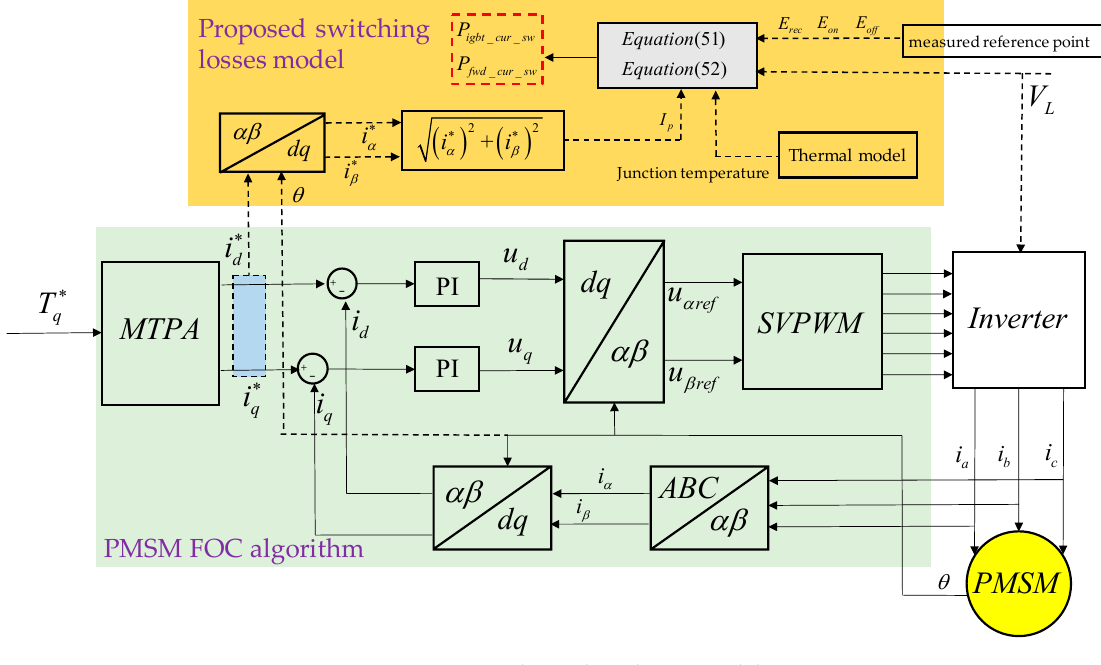
Figure 7. Proposed switching losses model.